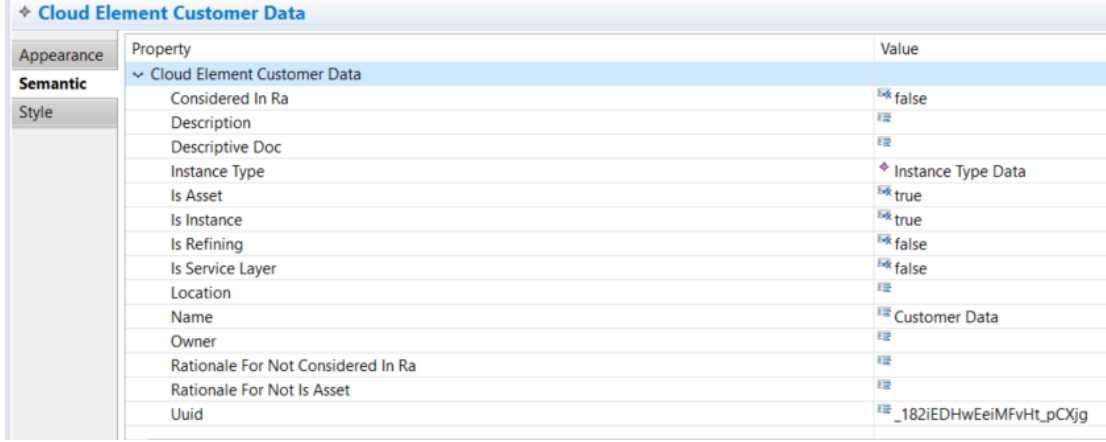
Figure 11. Definition of properties of the instantiated cloud element of the data instance